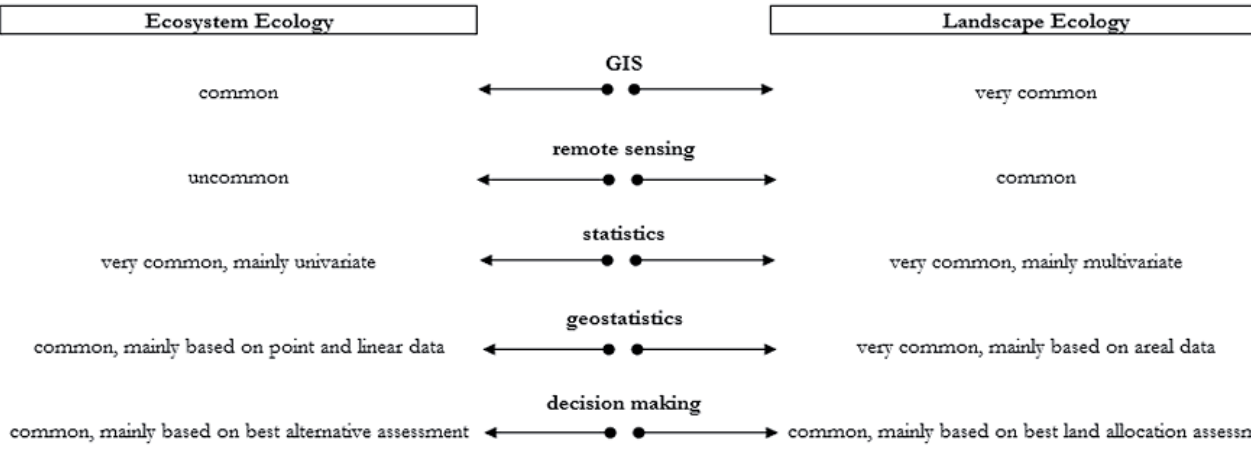
Figure 2: Schematic comparison between ecosystem and landscape ecology with respect to methodological issu-